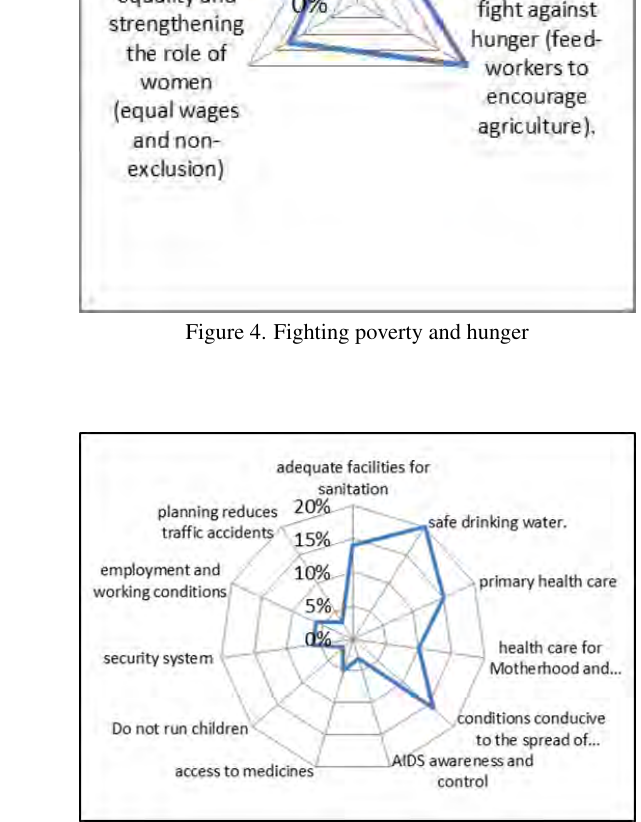
Figure 5. Promote health, safety and security